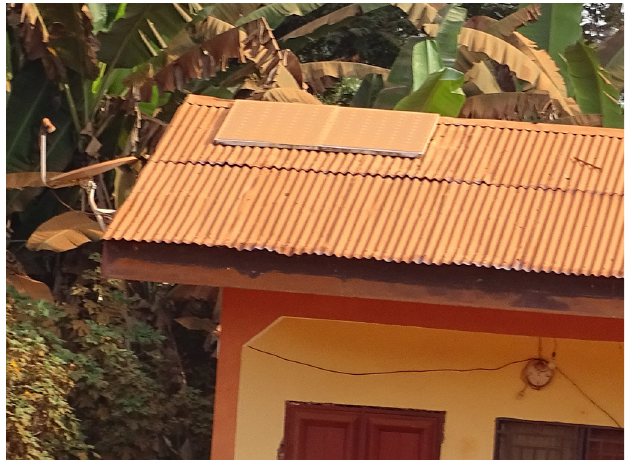
Fig. 6. Solar panel covered with dust in Lomie (cid:1) Cameroon (Photo J. Kenfack).